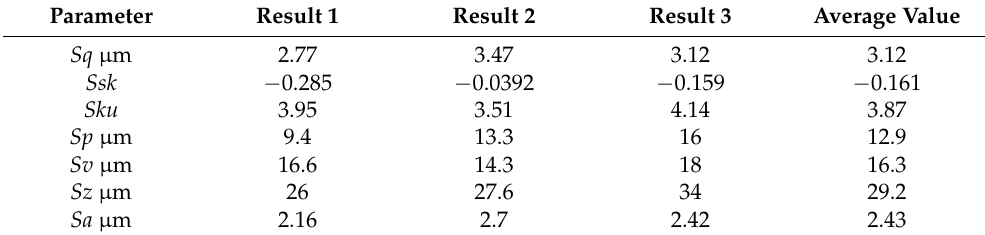
Table 4. Selected values of surface roughness parameters after laser sintering.